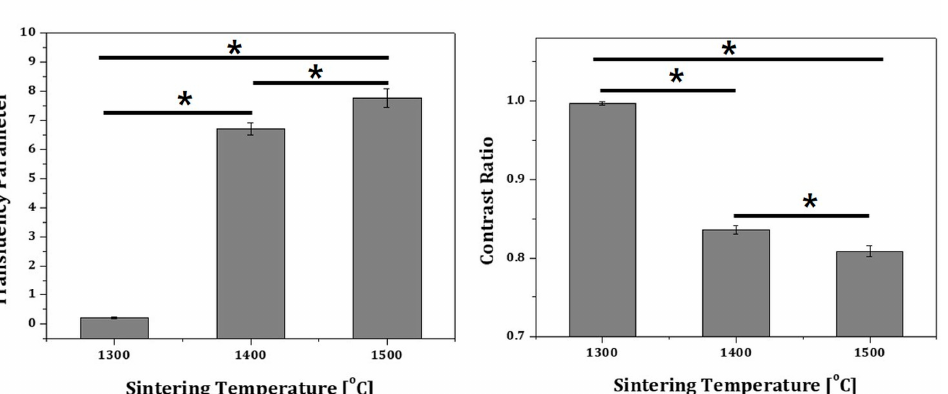
Figure 15. Optical images showing ( A ) 3D shape of a 4Y-PSZ dental crown sintered at 1500 °C for 3 h and ( B ) its translucency placed onto colored lines under light illumination.